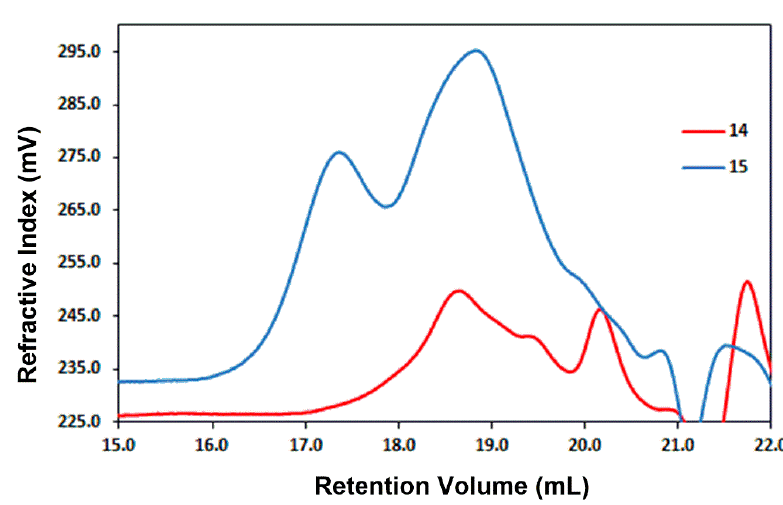
Figure 8. GPC chromatograms of polystannanes 14 (red) and 15 (blue).